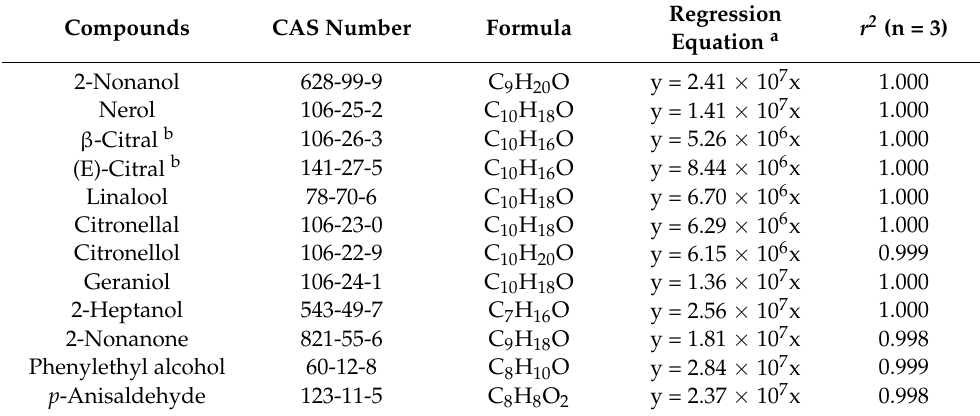
Table 7. Basic information and calibration curve characteristics of 12 standards